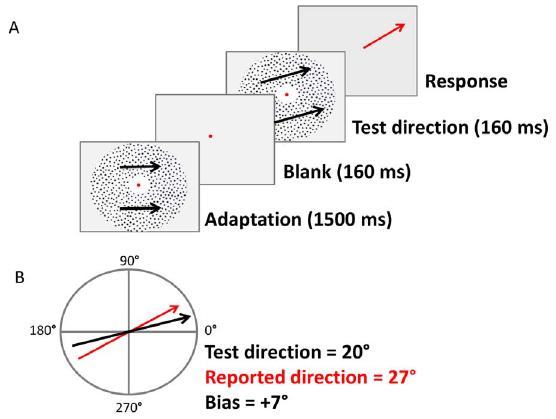
Figure 1. Trial sequence for Experiment 1. (A) Each trial began with the presentation of the experimental motion for 1500 ms, followed by 160 ms of a blank screen. A test stimulus with a randomly chosen direction was then presented for 160 ms, followed by a blank screen. The participant reported their perceived direction of the test motion by extruding a red response arrow from the centre of the screen using a computer mouse. The error (bias) on each trial was calculated as the difference between the true and reported directions